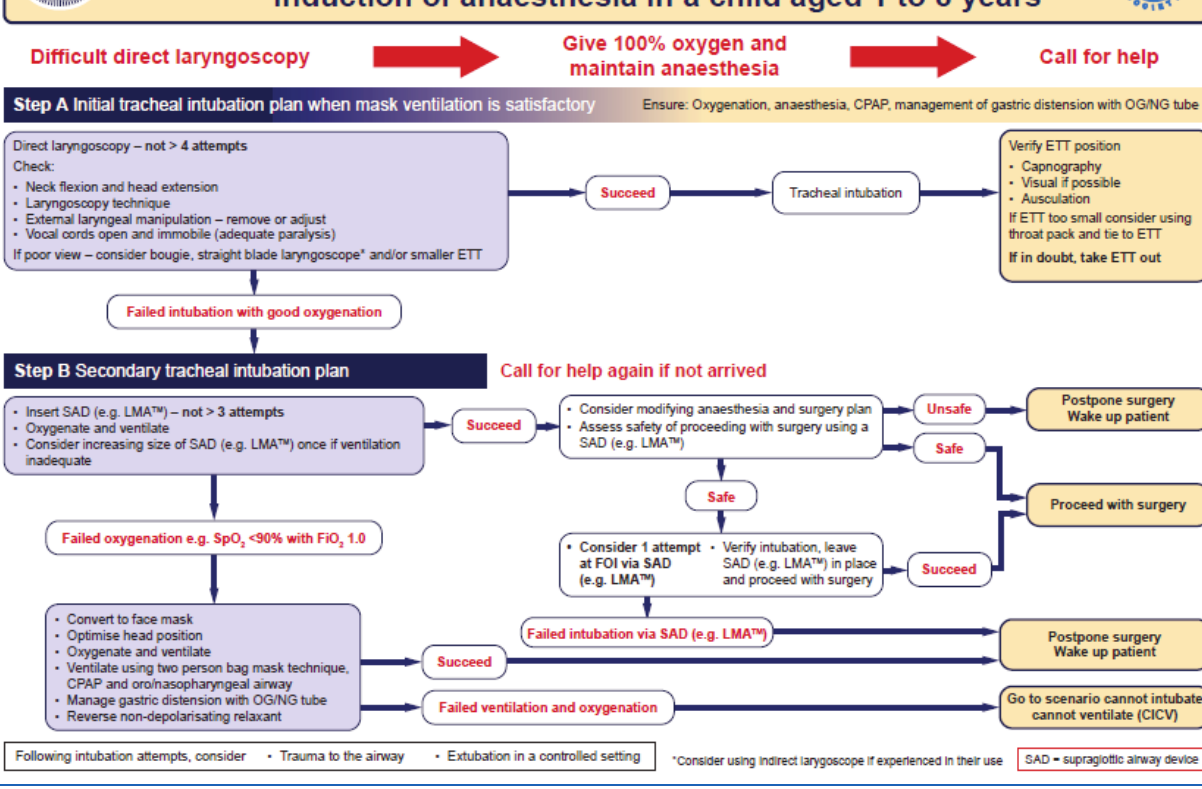
Figure 1. Unanticipated difficult tracheal intubation during routine induction of anaesthesia in a child aged 1 to 8 years